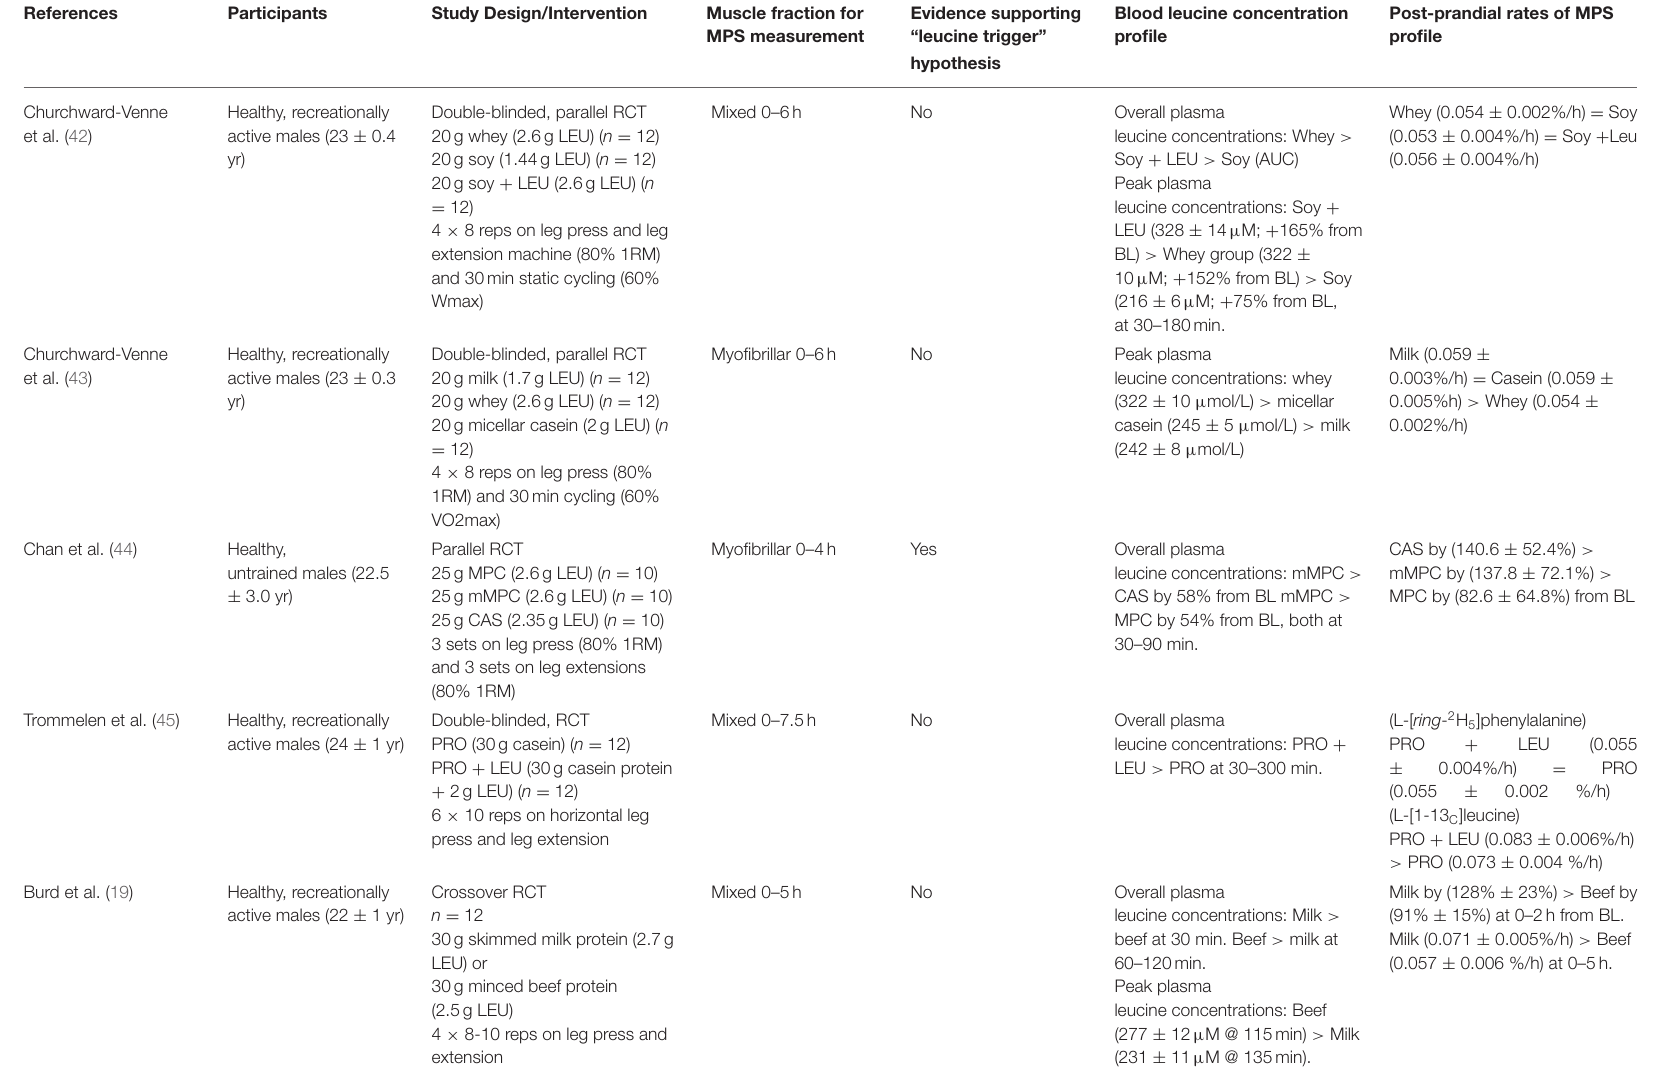
TABLE 4 | Summary of findings from studies that measured blood leucine concentration profiles and post-prandial rates of muscle protein synthesis following exercise in young